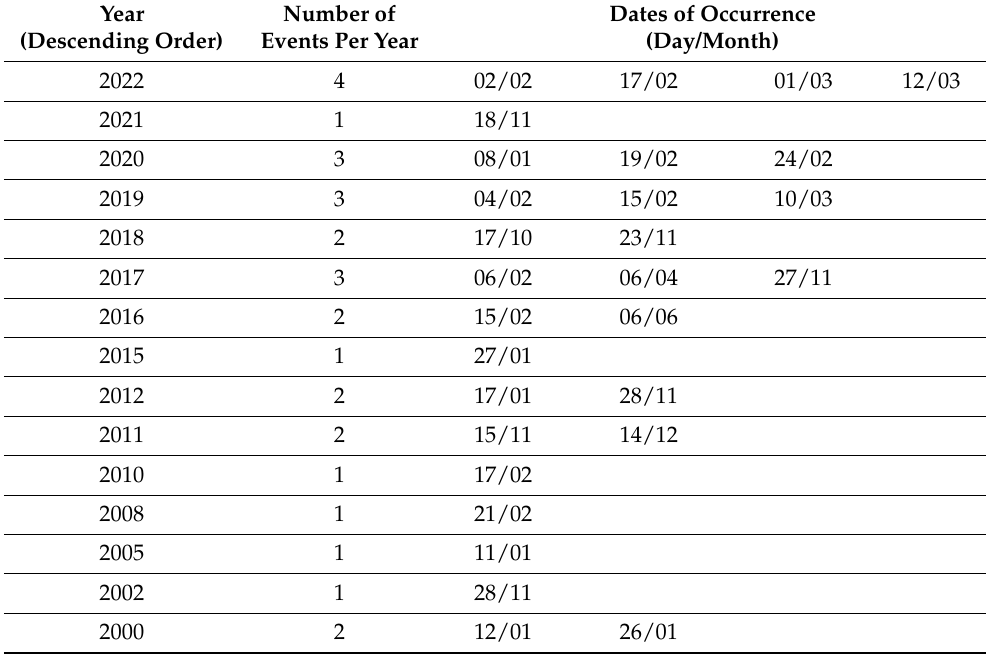
Table 1. Most relevant flood events in S ã o Caetano do Sul between 2000 and 2022 *.